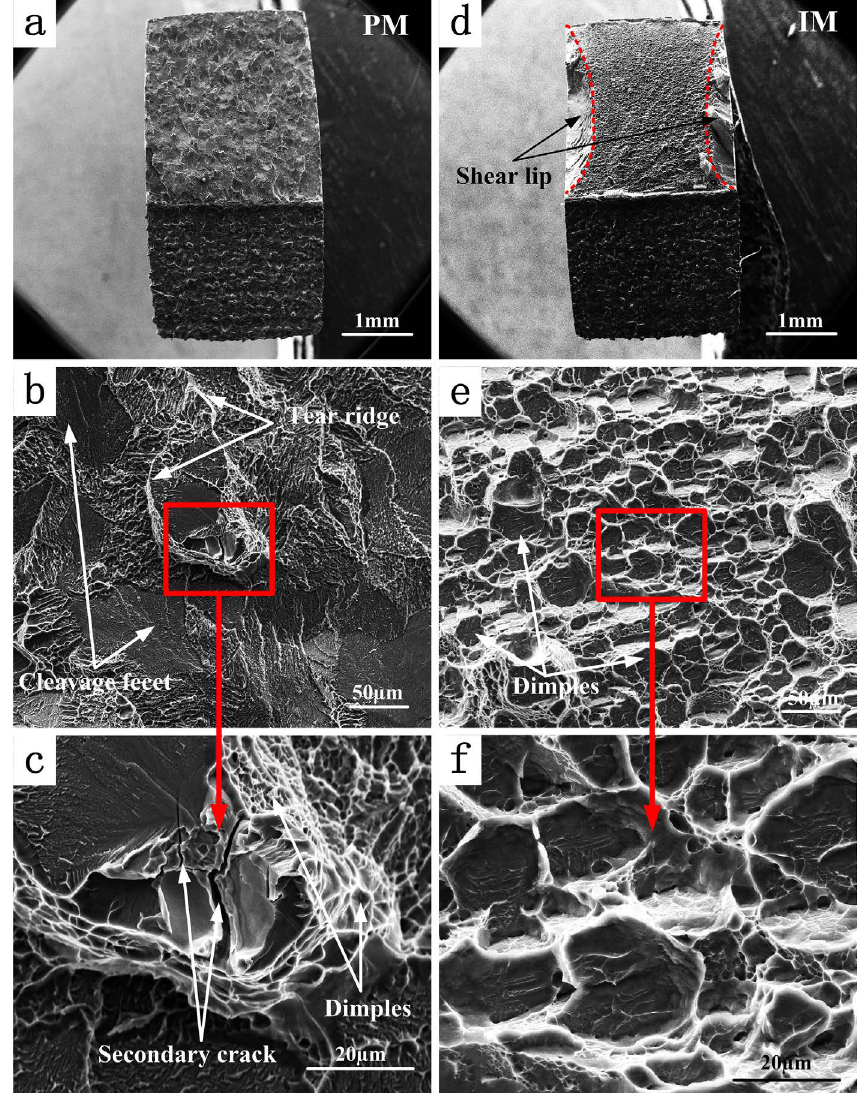
Figure 3. SEM images of macroscopical scale and microscopical scale fracture surface morphologies of the specimens after fracture toughness tests of as-consolidated PM and as-cast IM Ti-5553 alloys: (a) PM macroscopical scale; (b) and (c)PM microscopical scale; (d) IM macroscopical scale; (e) and (f) IM microscopical